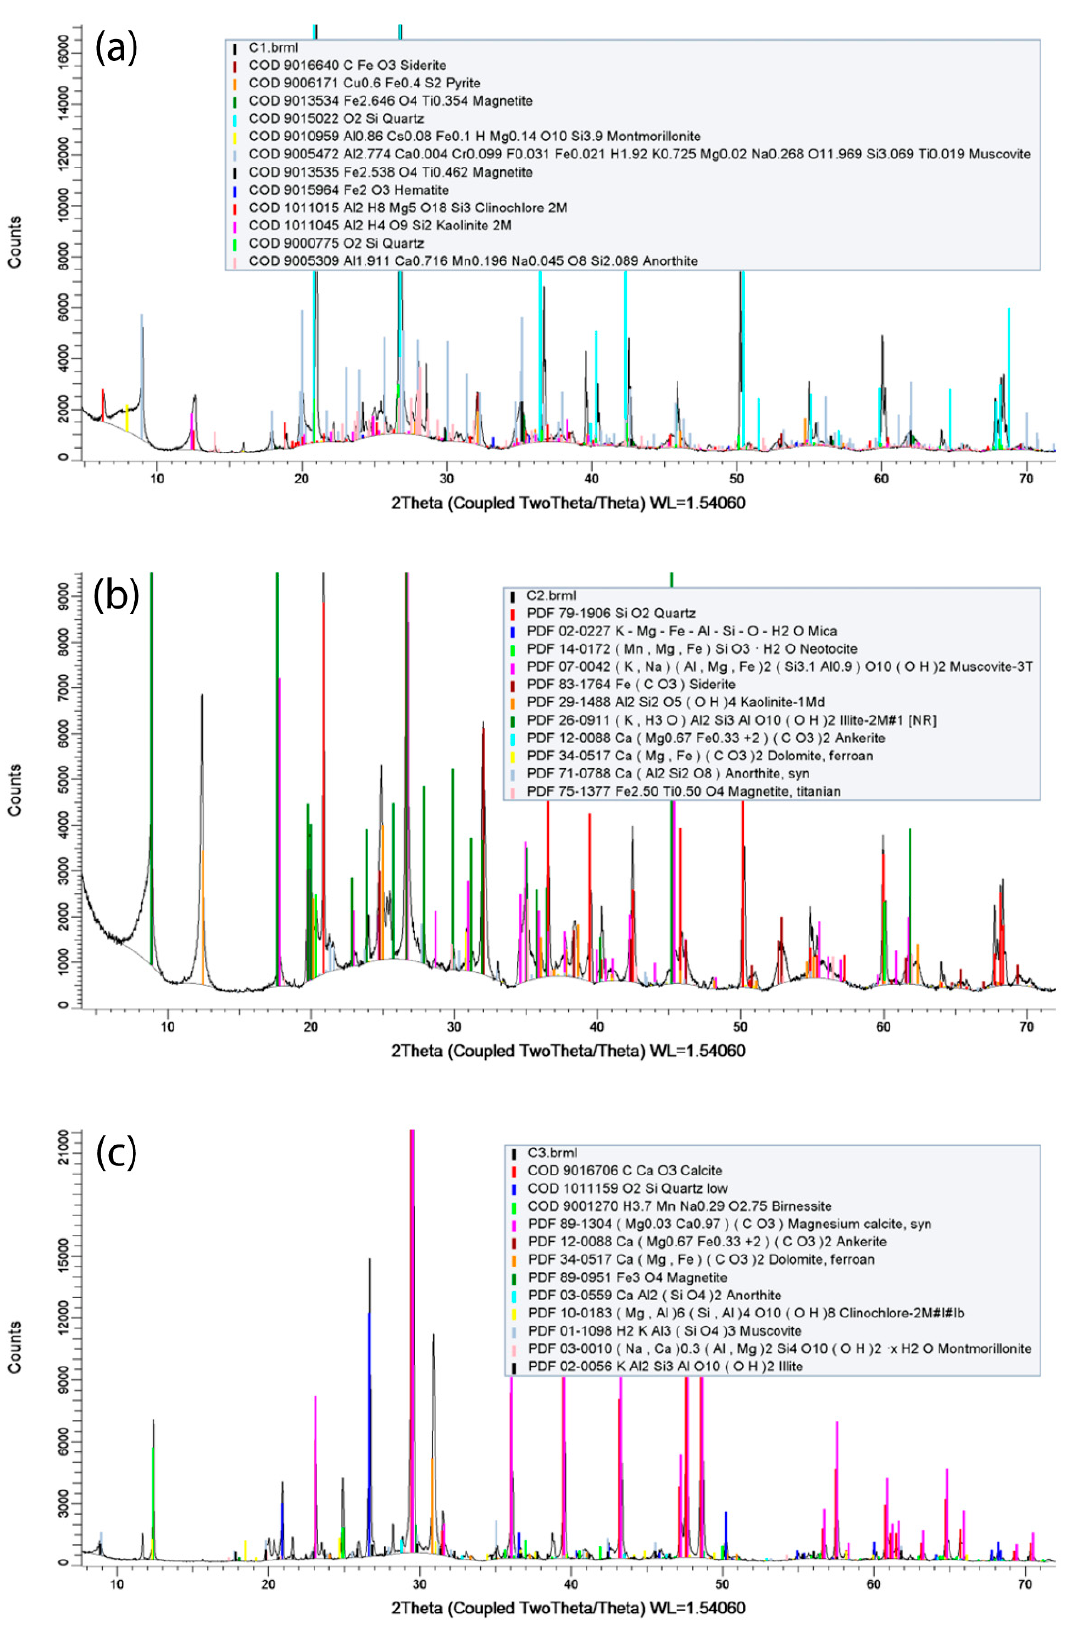
Figure 3. XRPD spectra and Rietveld refinement of rock samples. ( a ) C1 shale; ( b ) C2 shale; ( c ) C3 carbonate. Quantitative data results are in Table 1.